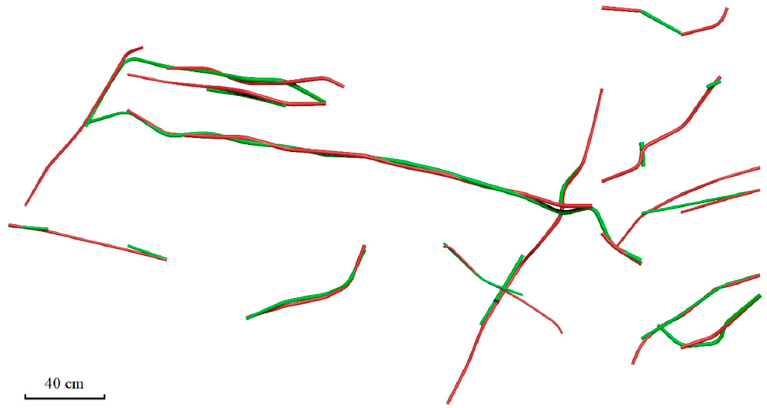
Figure 13. Comparison between actual measured (red) and ground-penetrating radar (GPR)-based reconstructed (green) 3D root system architecture (RSA), presented in a ground plan view. Table 4. Accuracy of reconstructed root system architecture (RSA) in terms of total length, volume, and biomass assessed by comparison with measured RSA.